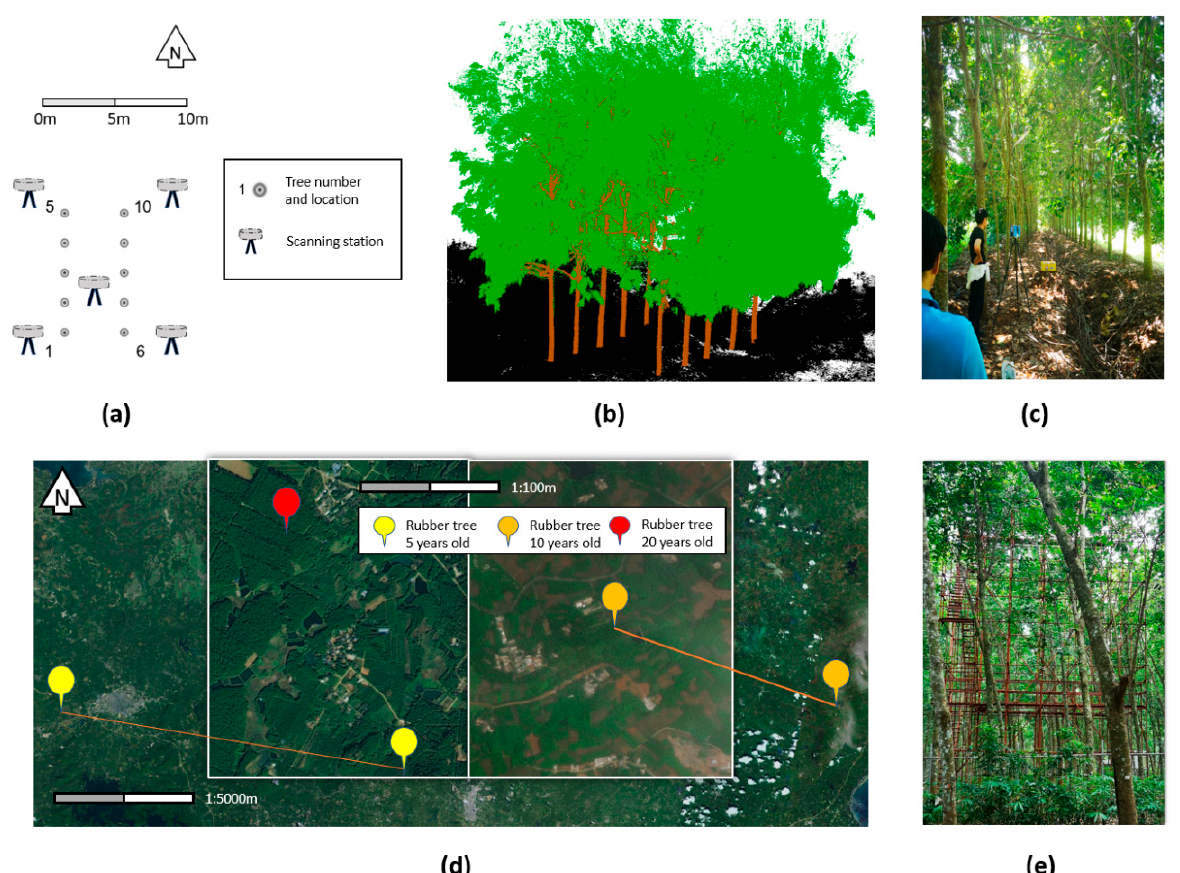
Figure 1. The study area and field measurements: ( a ) schematic layout of rubber trees, scanning positions; ( b ) point clouds of the five-year-old rubber trees—points in black refer to the classified ground points, points in brown refer to the classified stem/branches points, and points in green refer to the classified leaves points; ( c ) a scan position in the field measurement using Leica ScanStation C10; ( d ) locations of three sample plots; ( e ) the scaffolding system of branches measurements.